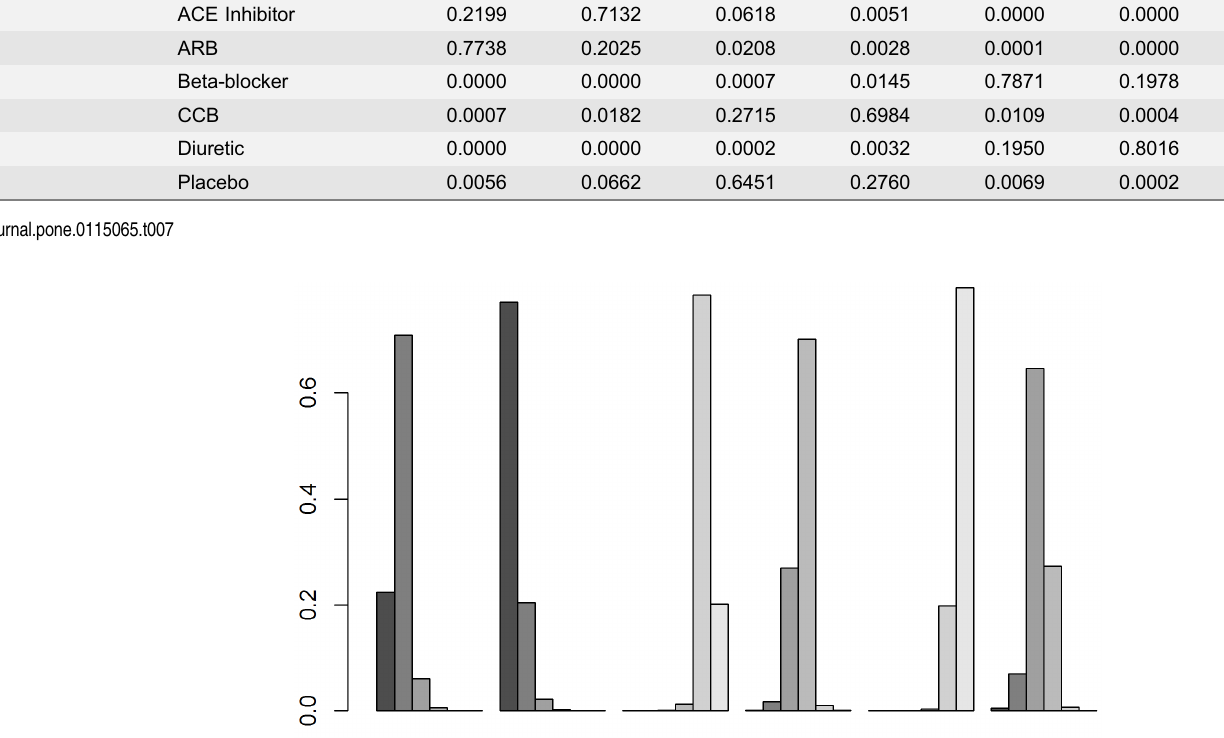
Table 7. Rank probability matrix displaying estimated ranks of treatments from the Diabetes dataset obtained from the gemtc package. Treatment Number